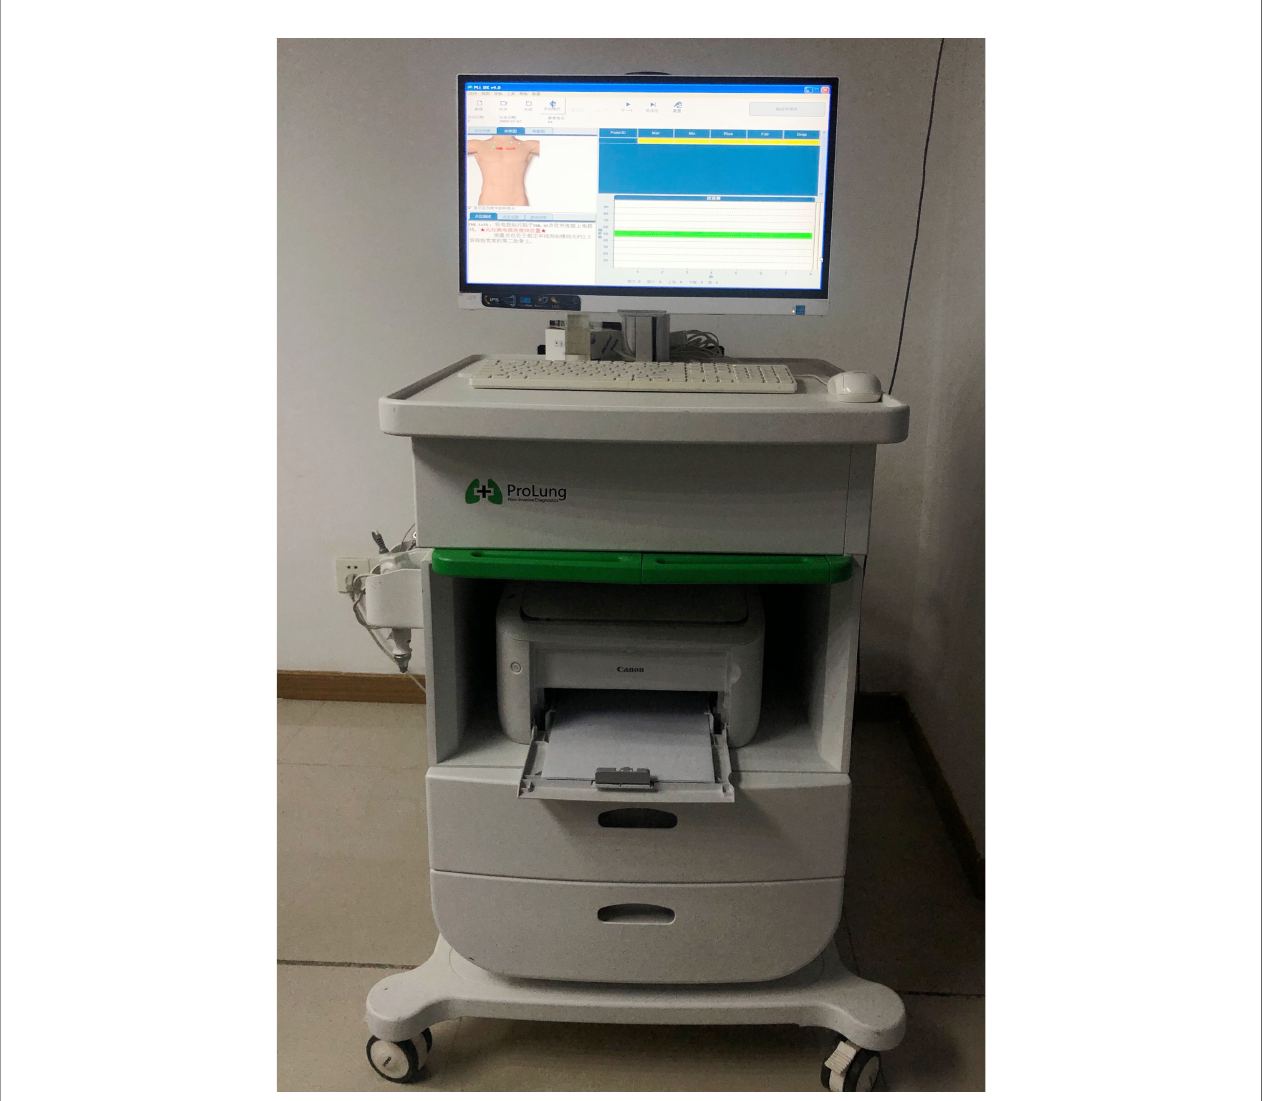
FIGURE 1 | Electrical impedance analysis (EIA)